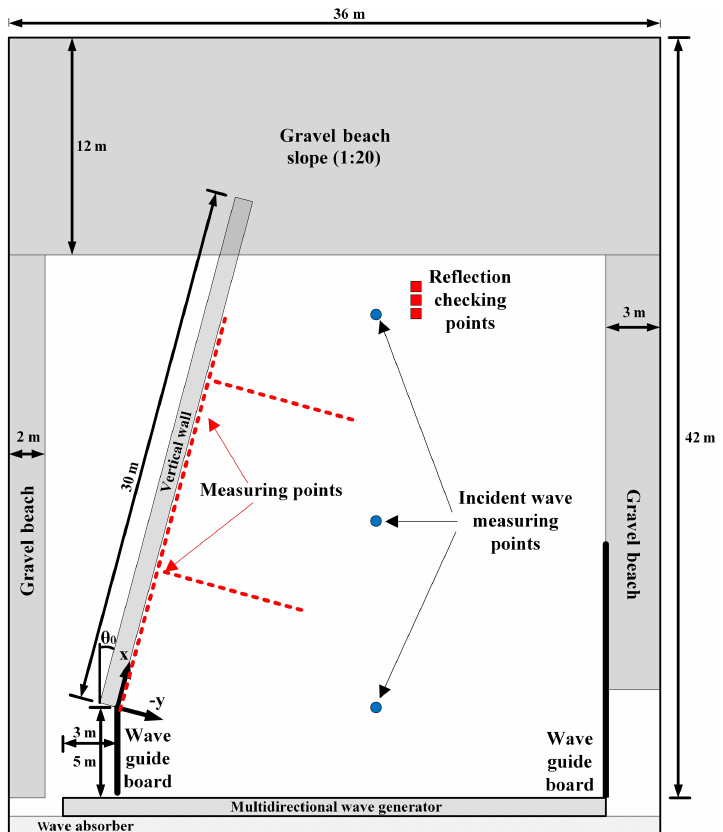
Figure 4. Definition sketch of the experimental